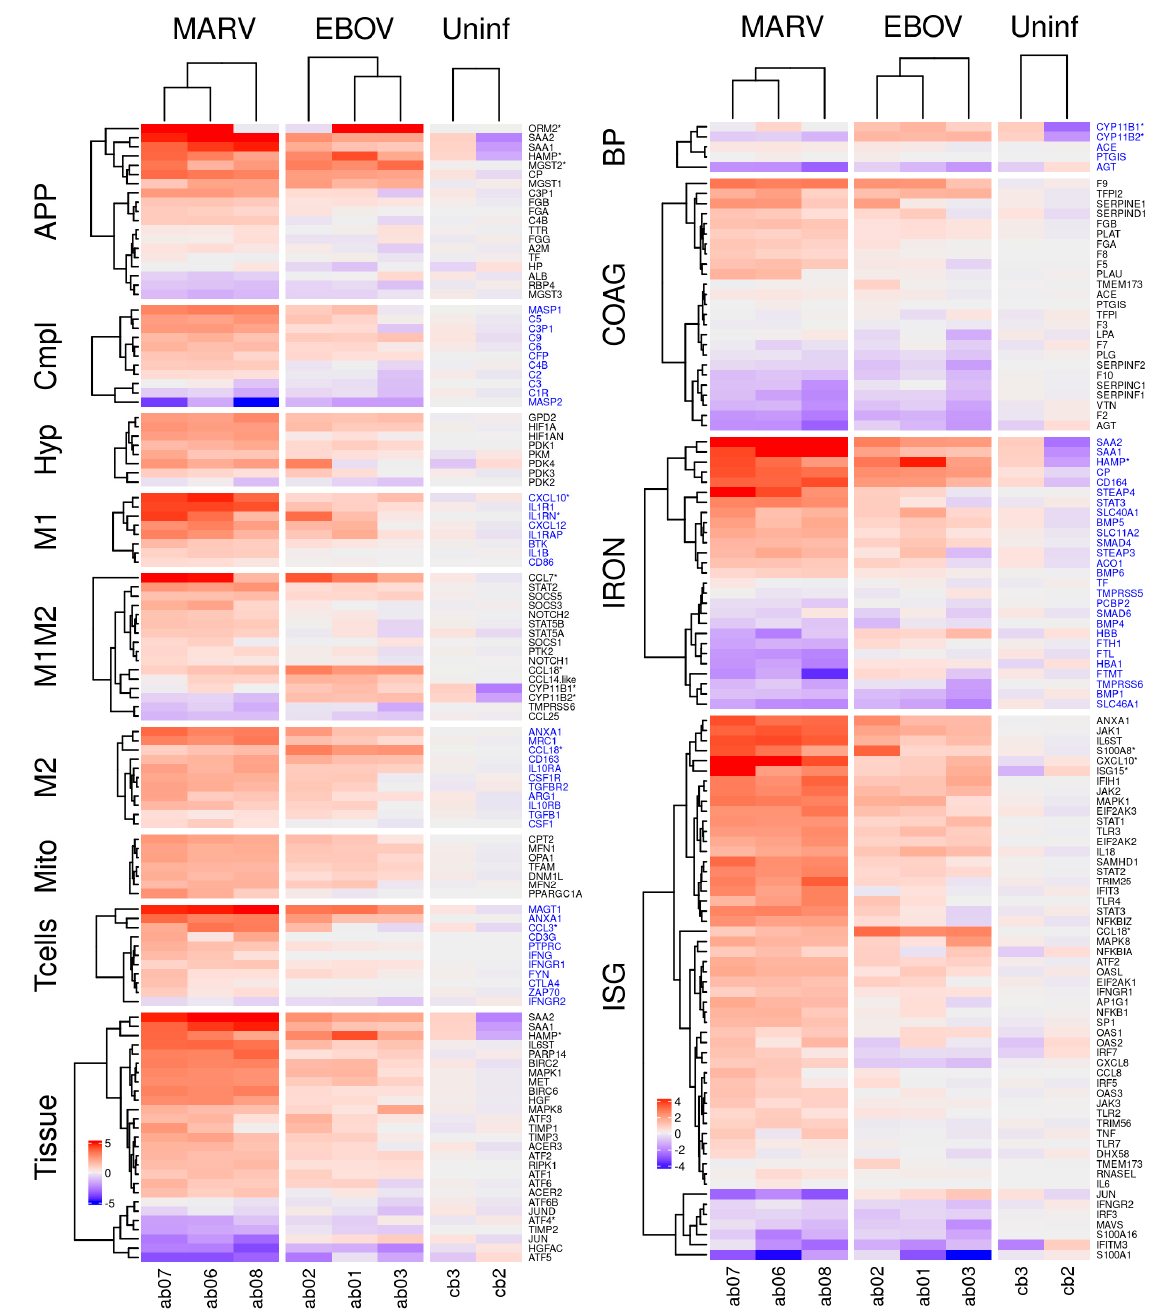
Figure 4. Differential expression of genes belonging to the indicated pathways by MARV and EBOV infections in livers of bats. The columns show differentially expressed genes from livers of three MARV-infected bats, three EBOV-infected bats and two uninfected bats. The values are log2 of the fpm values, with the mean values from uninfected animals subtracted. APP: acute phase response proteins; Compl: complement; Hyp: hypoxia related genes; M1 and M2: genes specific to M1 or M2 macrophages, respectively; M1M2: genes common to M1 and M2 macrophages; Mito: genes expressed in mitochondria; Tcells: genes expressed in T cells; Tissue: genes involved in tissue regeneration and apoptosis; BP: genes involved in regulation of blood pressure; ISG: interferon stimulated genes; IRON: genes involved in iron homeostasis; COAG: genes involved in coagulation. A * after a gene name indicates that the bat version is divergent from its human counterpart. Alternate blocks of gene names are colored black/blue to allow easy visual distinction of the blocks. Figure S2A,B show corresponding figures for kidneys and